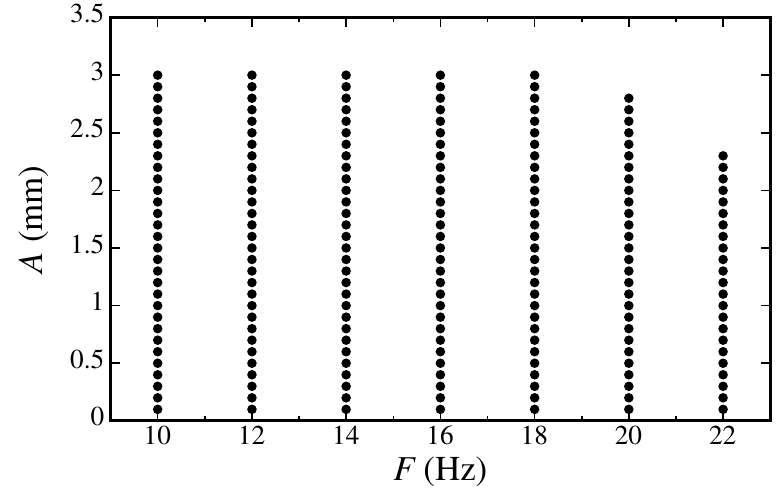
Figure 1. The dots represent the locus in the ( A , F ) -plane of the experimental tests. The same forcing frequencies and amplitudes are used for both types of cell